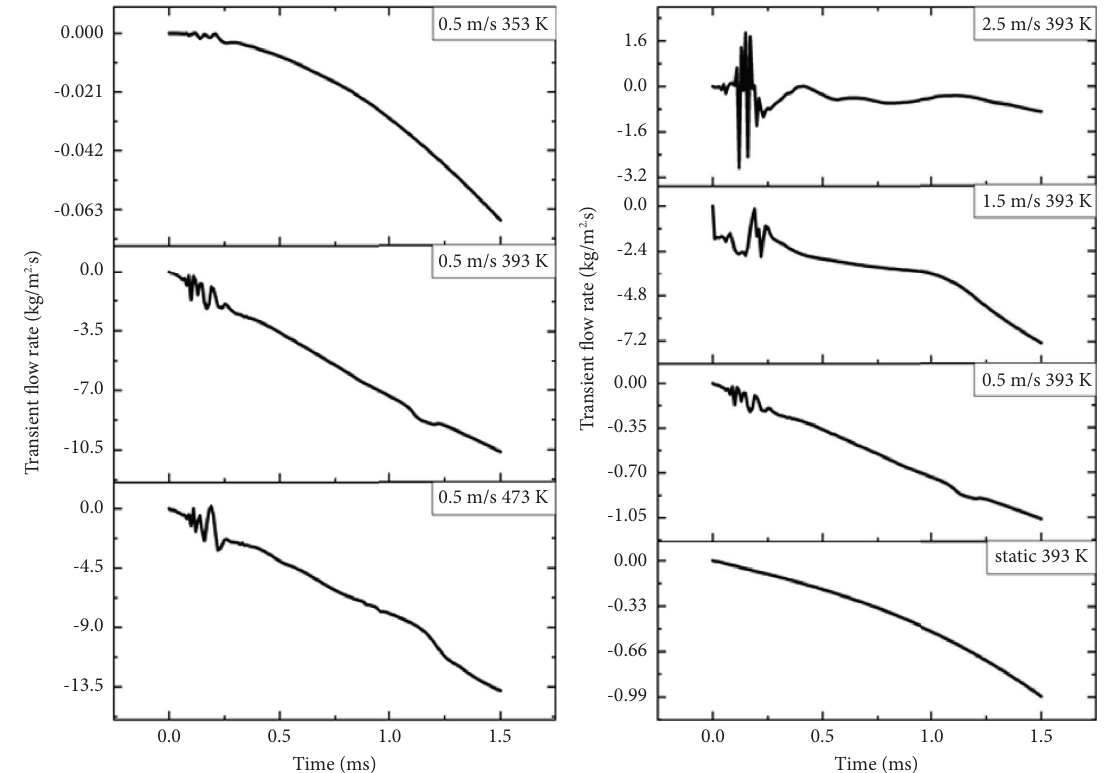
Figure 11: Transient fow rate of the liquid phase during the collision.